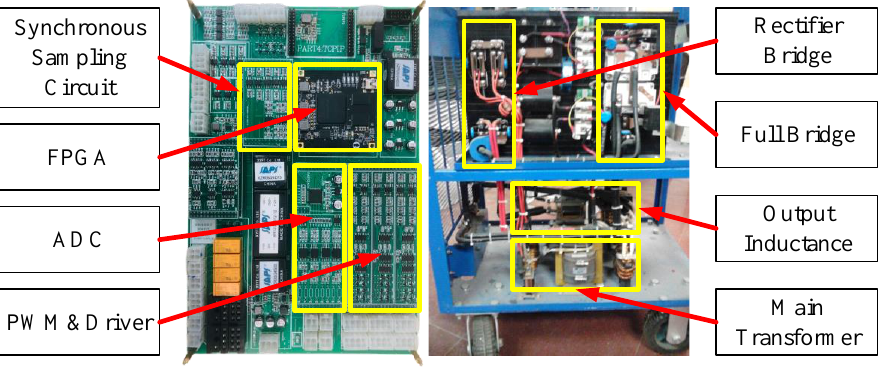
Figure 14. Experiment platform.